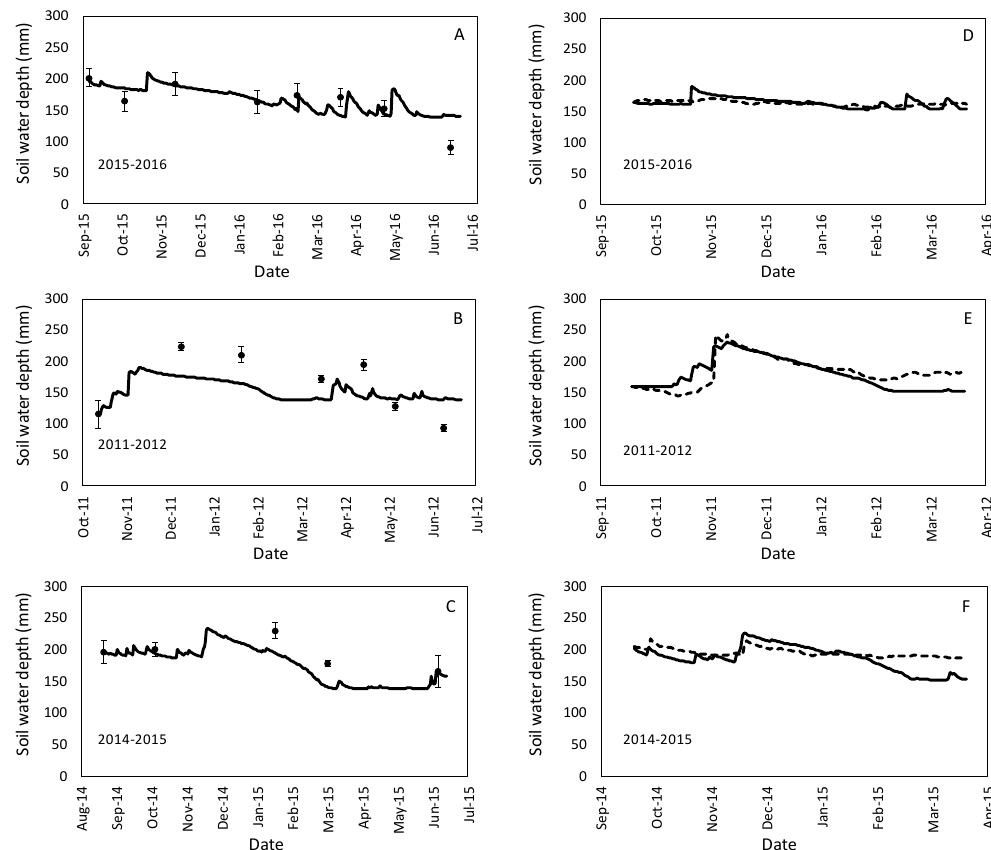
Figure 8. Total soil water content (0–90 cm) in the soil profile measured from disturbed soil samples ( A – C , circles), with ECH2O sensor ( D – F , dashed line) and simulated with LEACHM model (continuous line). Calibration (2015 / 16) and validation (2011 / 12 and 2014 / 15) periods under barley cropping are shown (vertical bars represent the standard deviation).